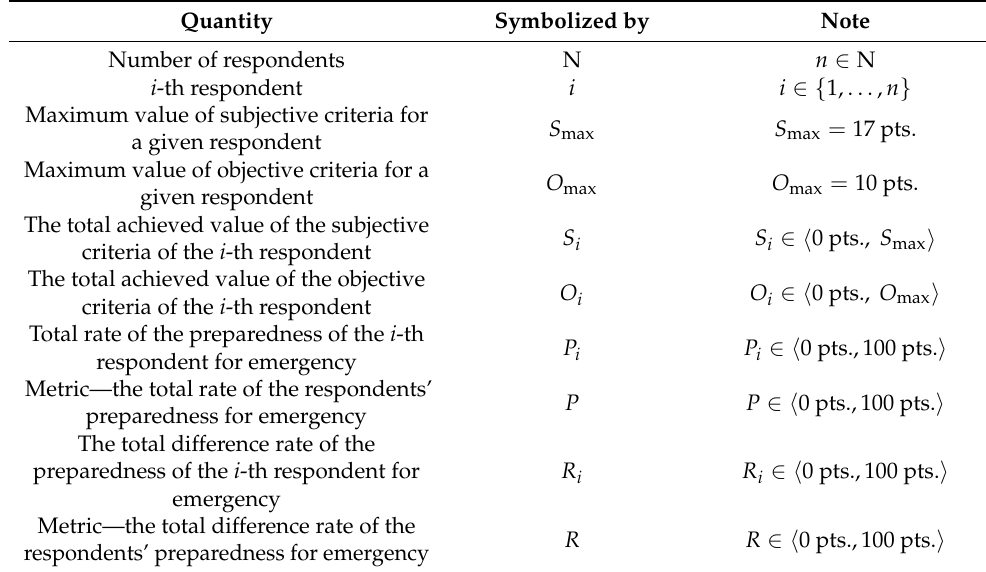
Table 3. Qualification of the quantities